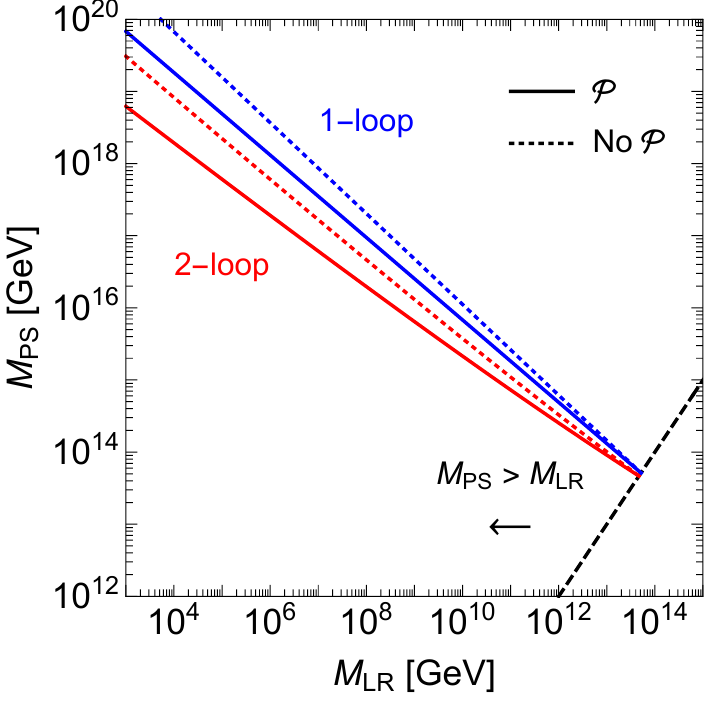
Figure 1 . Pati-Salam uni(cid:12)cation scale as a function of the Left-Right symmetry breaking scale, from a one-loop (blue lines) and a two-loops (red lines) RG analysis. The full (dotted) lines corre- spond to the case where P is broken at the M LR ( M PS )